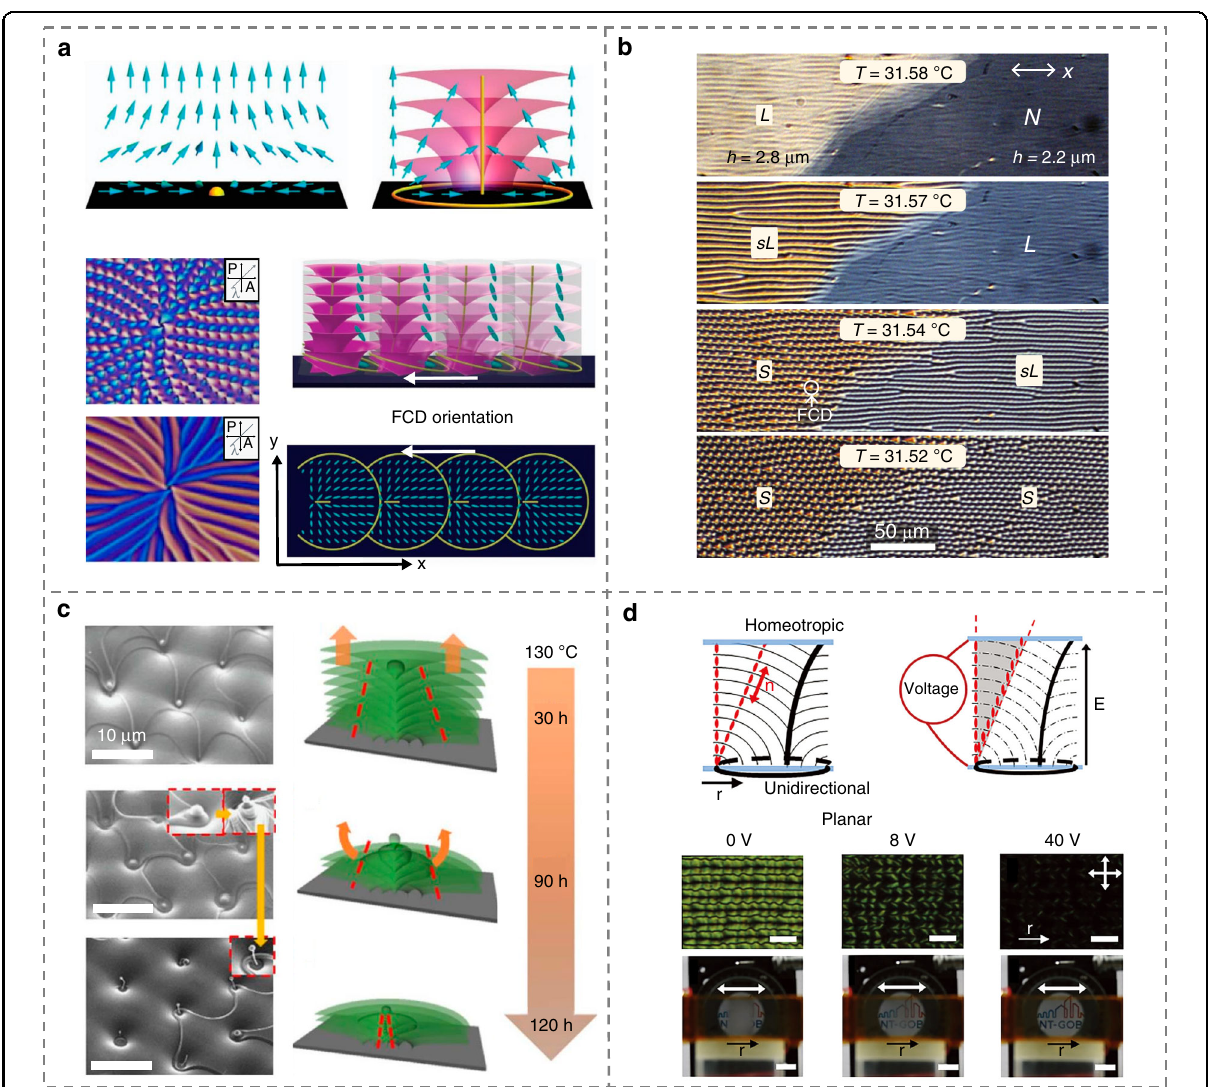
Fig. 5 Manipulations of SLC topological defects by thermal and electric fi elds. a and b Dynamic defect morphogenesis during nematic-smectic phase transition 102,103 . Reproduced from ref. 102 , with permission from Springer Nature: Nature Communications. Reproduced from ref. 103 , with permission from National Academy of Sciences. c Sintering-induced Udumbara fl ower-like microstructures 105 . Reproduced from ref. 105 , with permission from Springer Nature: Nature Communications. d Electrically reversible tuning of smectic FCDs 107 . Reproduced from ref. 107 , with permission from